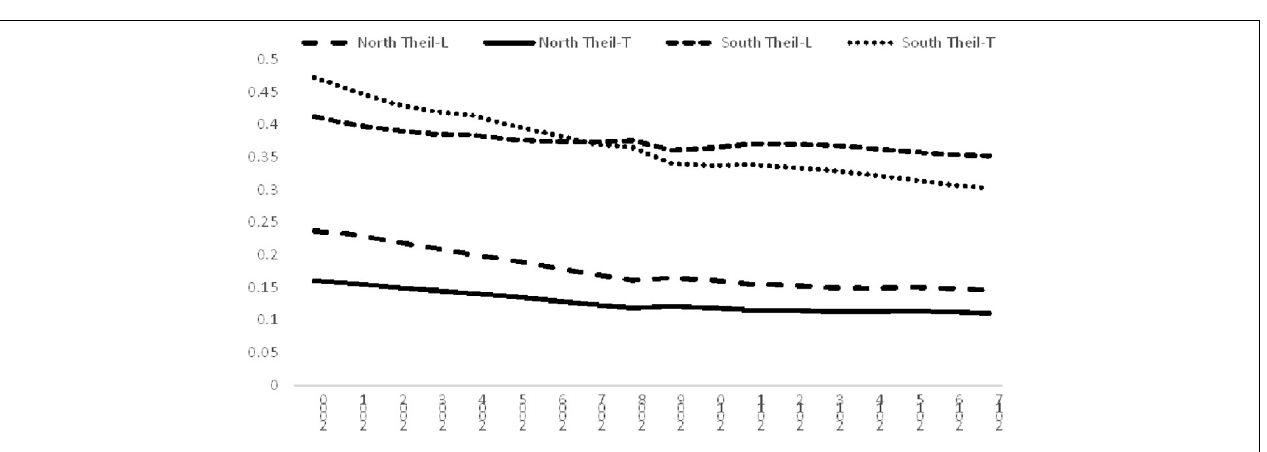
FIGURE 2 | Income inequality for the North and South, 2000–2017. Source: Authors’